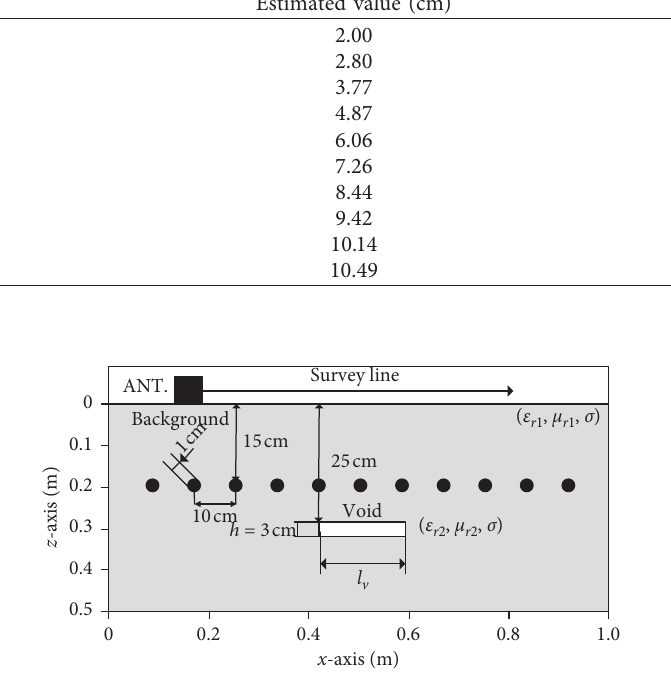
Figure 11: Void defect model with